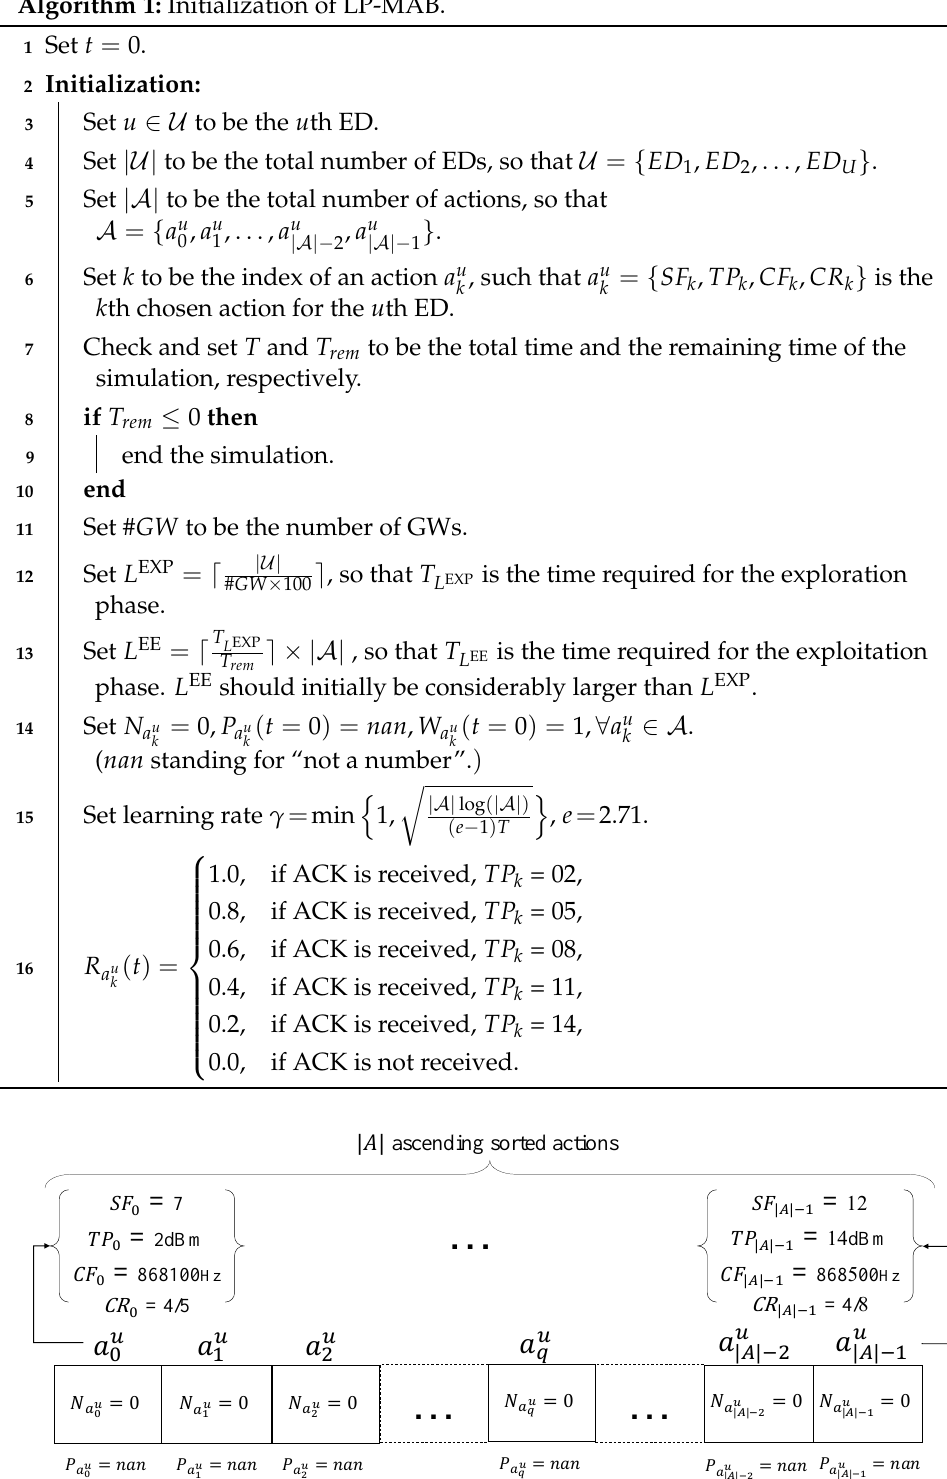
Algorithm 1: Initialization of LP-MAB.